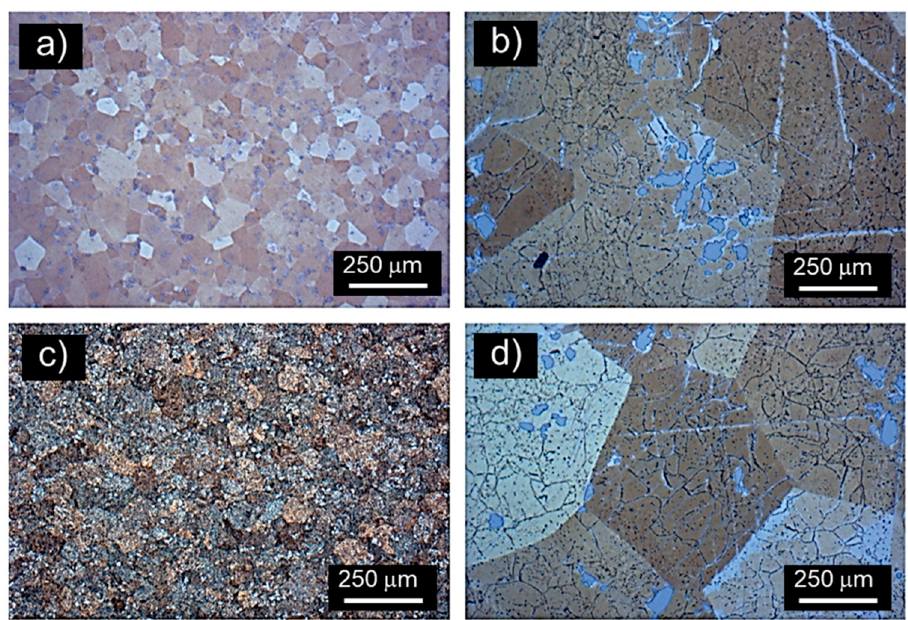
Figure 2. Microstructure of the samples thermally treated by ( a , b ) quenching and ( c , d ) normalizing.